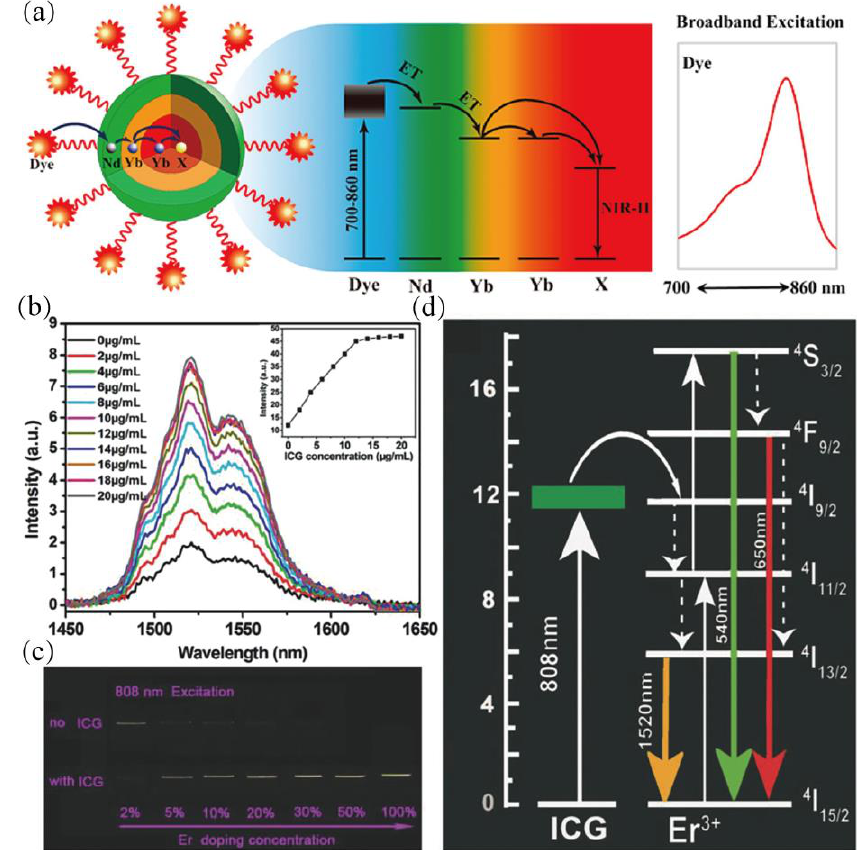
Figure 5. ( a ) Schematic illustrations of the energy transfer pathway from dye on the surface of LnNCs. Adapted, with permission, from Ref. [54]. Copyright 2016, American Chemical Society. ( b ) NIR−II fluorescence emission of LnNCs with different concentrations of ICG. ( c ) The luminescence photographs of LnNCs with ICG. ( d ) The mechanism of ICG-sensitized LnNCs. ( b − d ) Adapted, with permission, from Ref. [55]. Copyright 2018, Wiley−VCH.